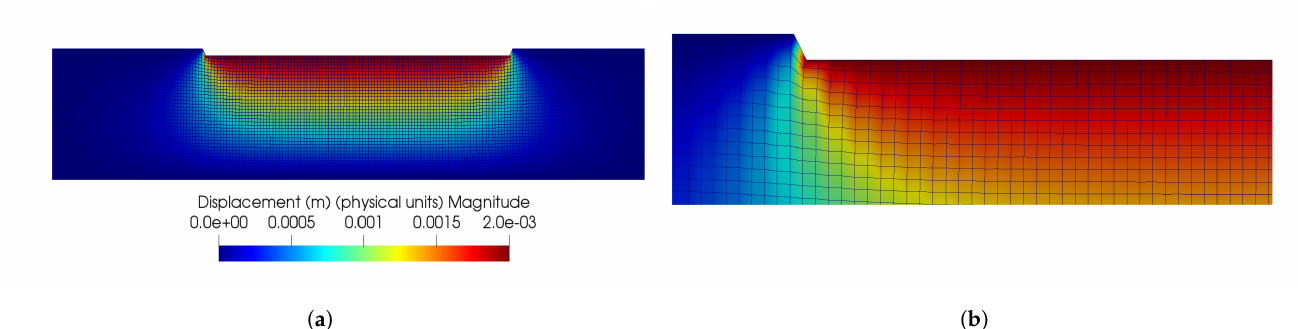
Figure 3. Deformed solid for case E = 200 GPa, ν = 0.15 amplified 5 times with its distorted underlying lattice. Color mapping shows magnitude of displacement field. ( a ) Overall view of the deformed solid. ( b ) Detailed view along loading.